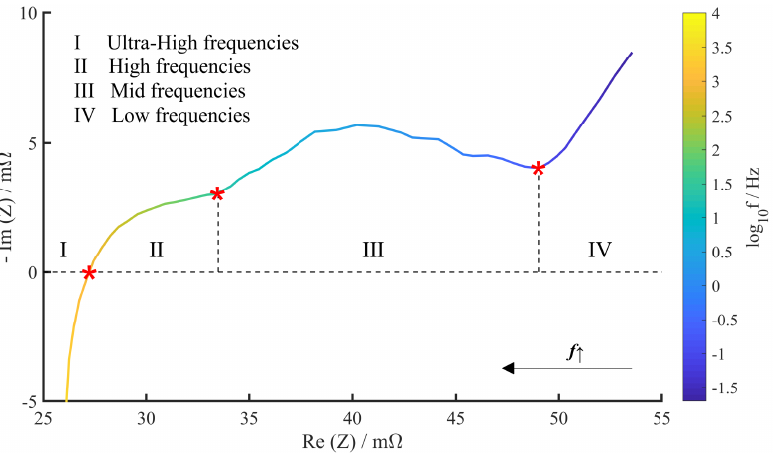
Figure 2. The impedance spectrum after 250 cycles of life test under 45 ◦ C@0.5–1 C condition, obtained at 20% SoC with 500 mA